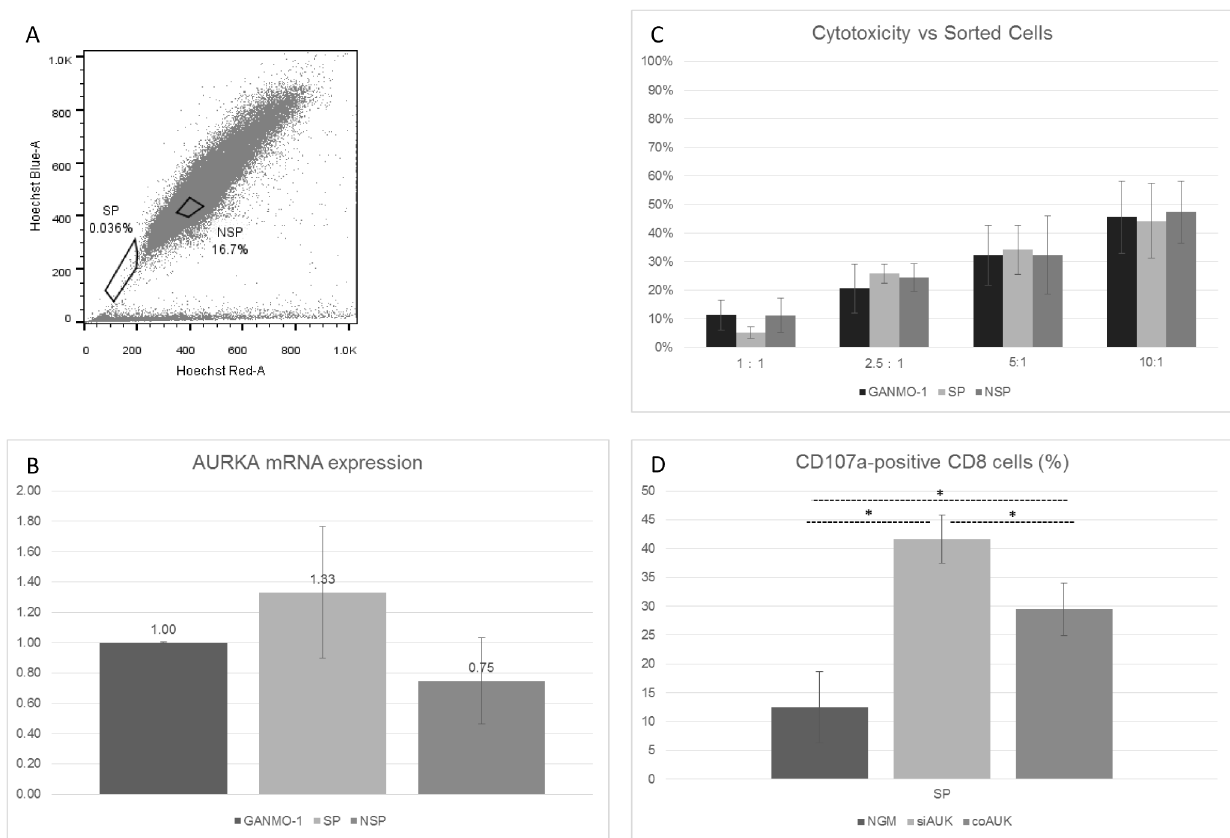
Fig 5. Characterisation of Side-Population (SP) cells, and Cytotoxic response against Side-Population cells. (A) — GANMO-1 cells were labelled with Hoechst 33342 and Propidium Iodide, and sorted by FACS. The ‘ side population ’ (SP) and a control ‘ non-side population ’ (NSP) gate are indicated. (B) – mRNA was collected from each sorted population, and unsorted GANMO-1 cells, and AURKA mRNA expression was determined by TaqMan RT-qPCR. (C) – Total cell killing was measured by Chromium-release assay following 3 hours co-culture of siAUK effector cells with unsorted GANMO-1 cells ( ‘ Unsorted ’ ), side-population cells, and non-side-population cells (n = 3). (D) – siAUK, coAUK, or NGM effector cells were co-cultured with SP cells for 3 hours in the presence of CD107a, then cells were analysed by FCM ( * p < 0.05, One-way ANOVA with Tukey ’ s test, n = 2, ±